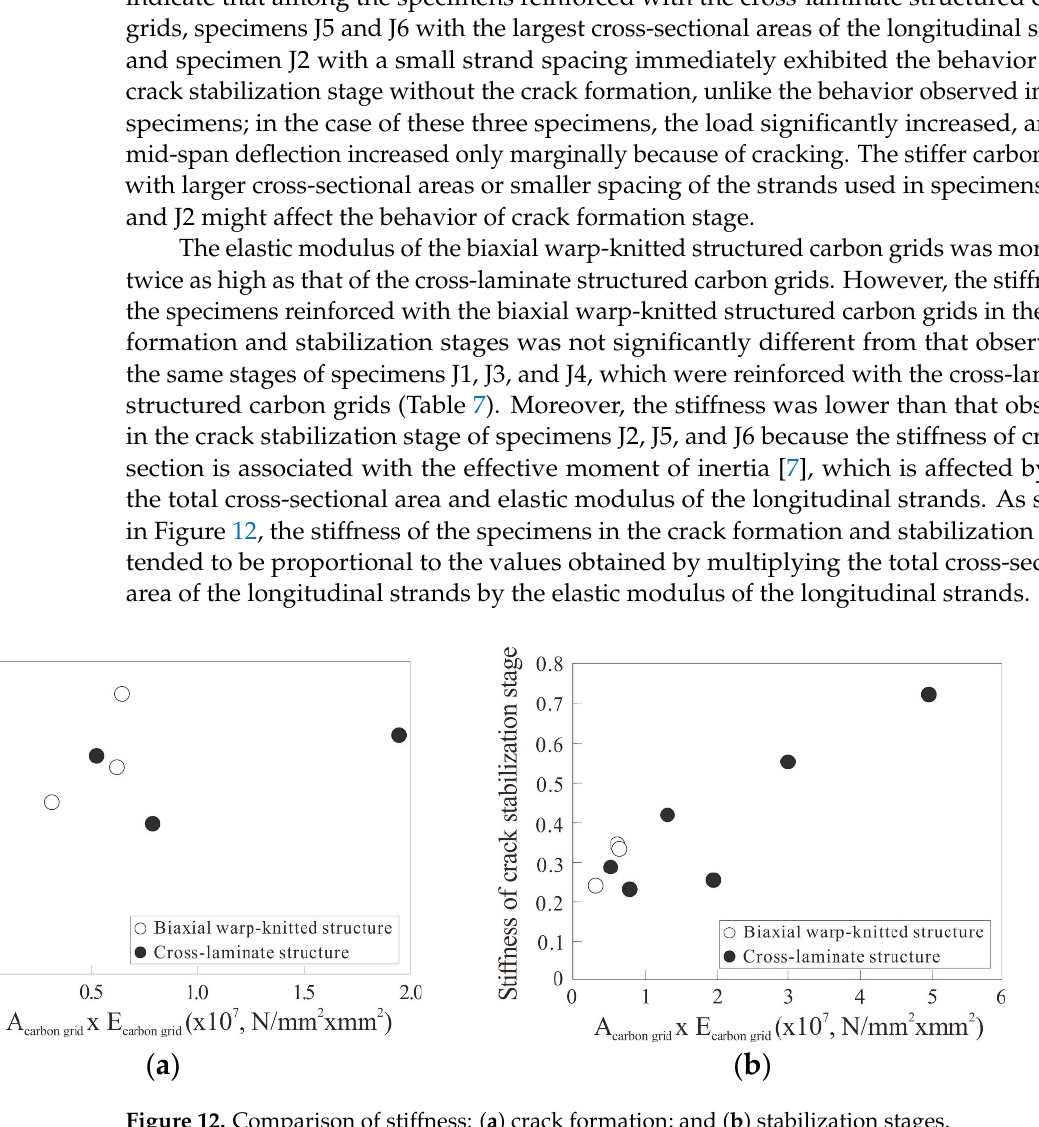
Figure 12. Comparison of stiffness: ( a ) crack formation; and ( b ) stabilization stages.